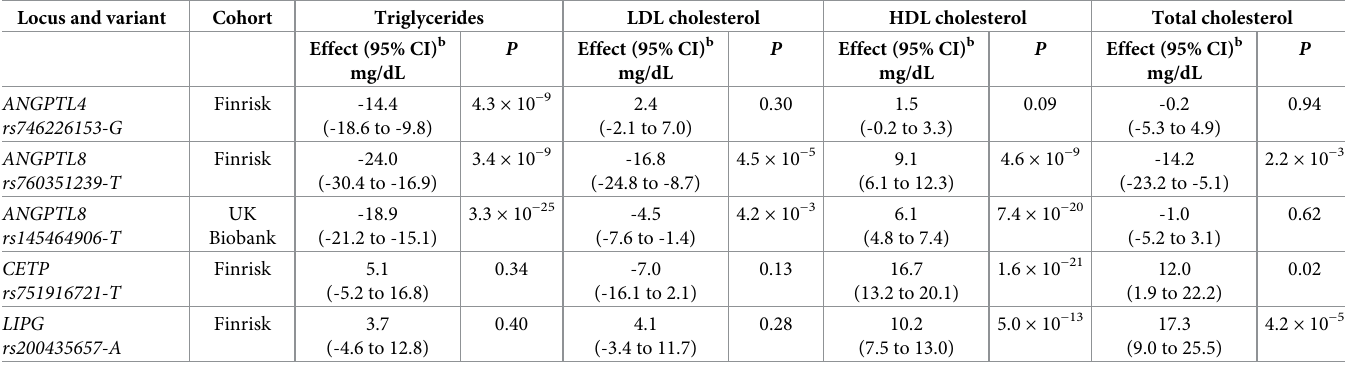
Table 2. Associations between protein-truncating variants and serum lipid levels in the Finrisk Study and UK Biobank. a